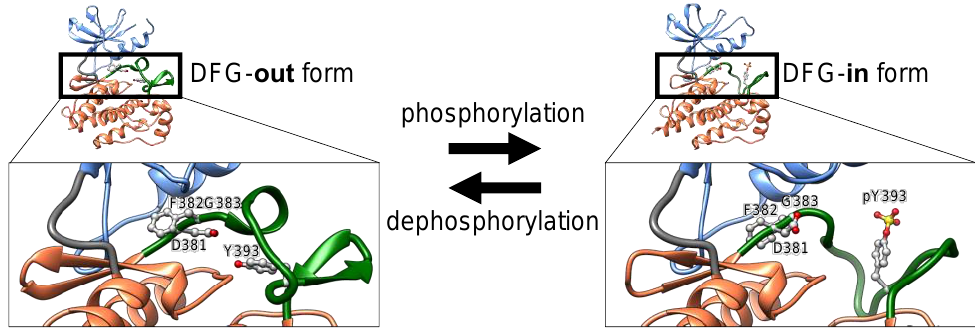
Figure 3. Enlarged view of the conformational transition of the ABL kinase domain between inactive DFG-out and active DFG-in states by activation loop phosphorylation and dephosphorylation. Structures of the DFG-out and -in forms are illustrated from PDB IDs 2HYY and 2V7A, respectively. The colors indicate the same regions shown in Figure 1. The orientation of the phenyl group of F382 is dynamically altered in the transition.